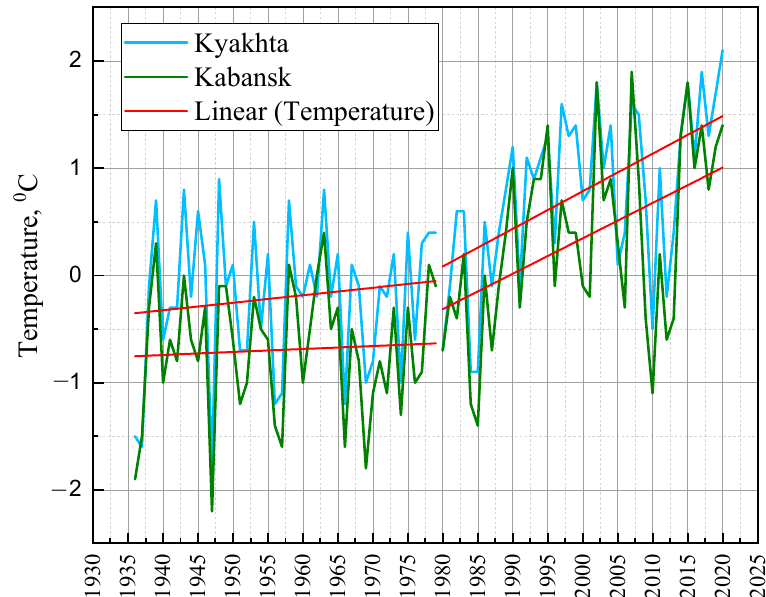
Figure 12. Changes in air temperature for the period of 1936–2020. The analysis revealed an insignificant downward runoff trend at two hydrological stations in the Russian part of the Selenga basin. The maximum runoff and precipitation levels were recorded in the summer months and the first half of autumn. The lowest runoff values were in the winter period. Analysis of precipitation and runoff data in the Mongolian part of the Selenga River basin, performed by scientists from different countries, also showed a negative trend at some hydrological stations [15]. To assess the correlation between precipitation and runoff, we calculated Spearman rank correlation coefficients of the average annual data for two stations—Novoselenginsk and Mostovoi (Figure 13), for which a weak (r = 0.37) and a moderate correlation (r = 0.53) was identified, respectively.